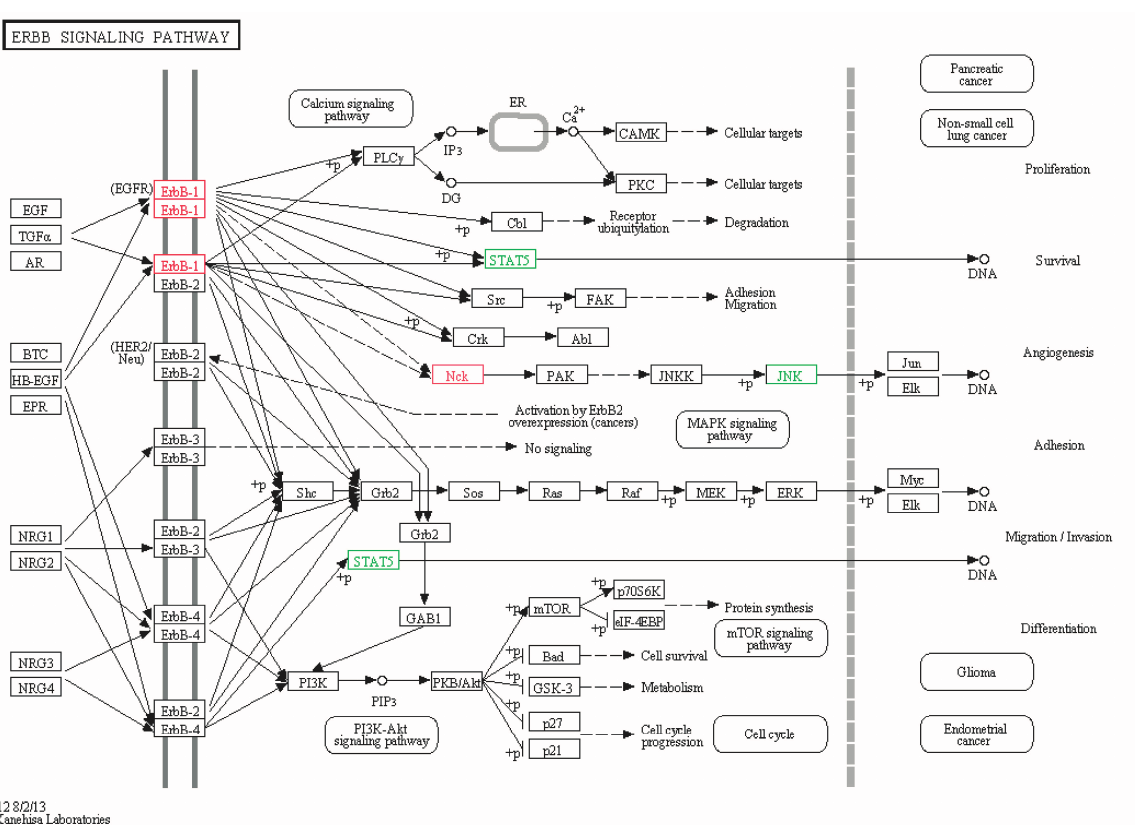
Figure 11. ERBB signaling pathway. Red boxes represent up-regulated genes, and green boxes represent down-regulated